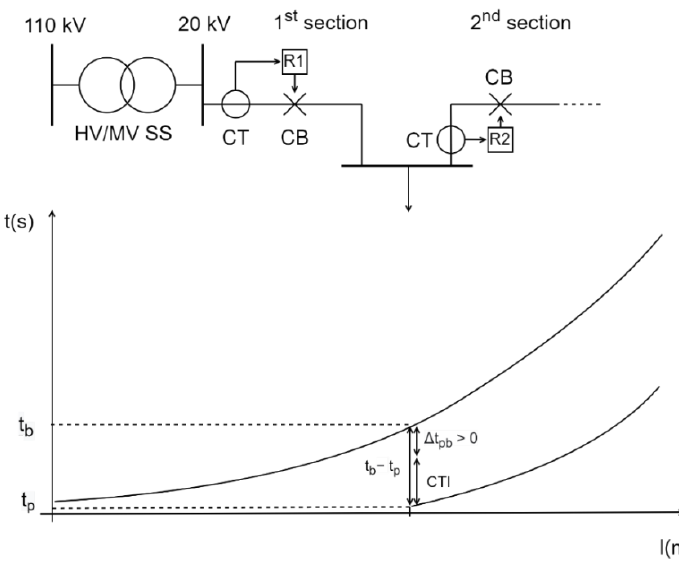
Figure 1. Minimization of time difference between P/B relay pairs.